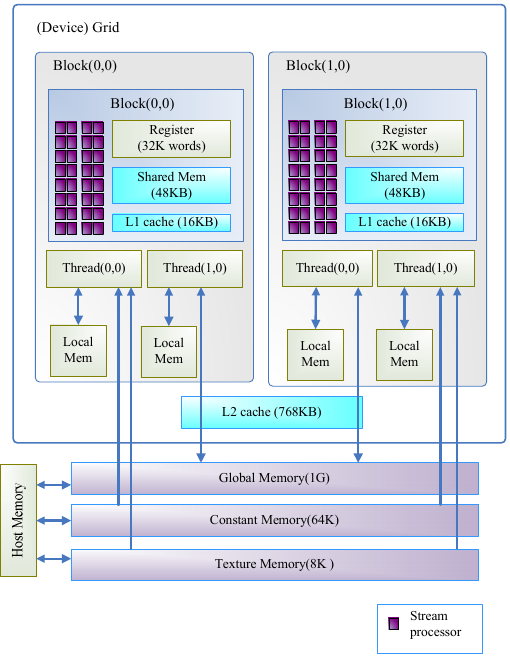
Fig. 2. Memory architecture of CUDA device, nVidia GTS450.